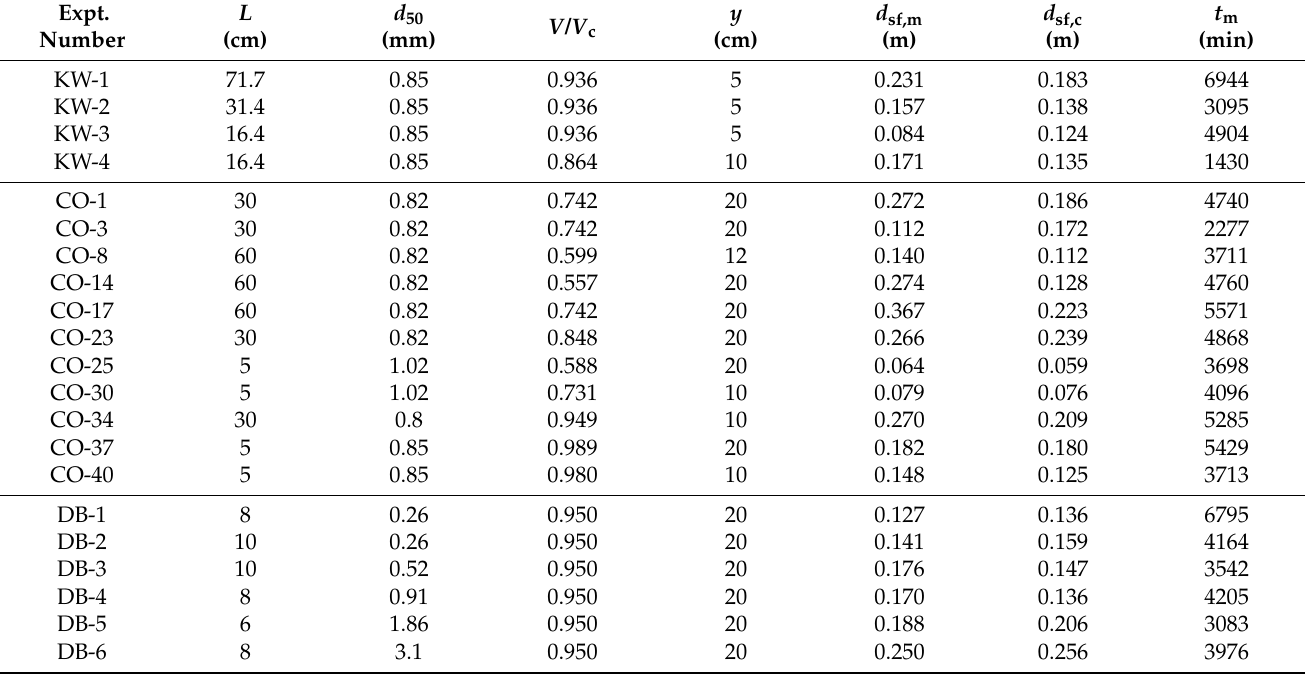
Table 2. Summary of rectangular/vertical-wall abutment scour under clear water steady flow